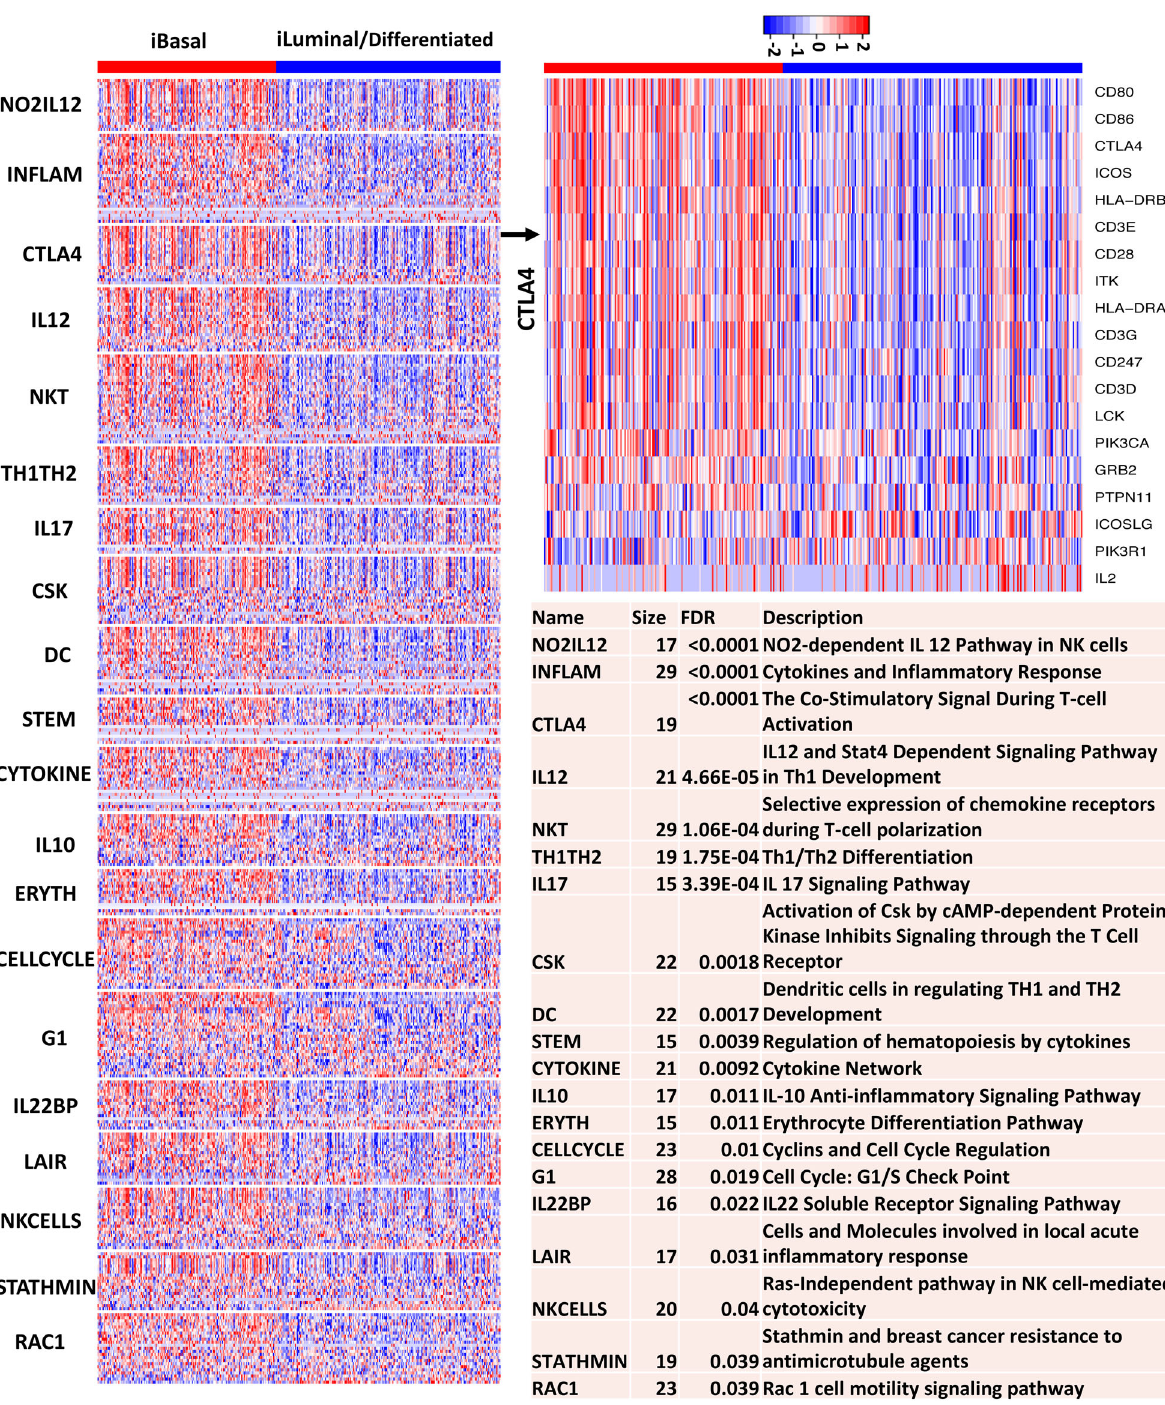
xCell analysis of 64 cell types for each TCGA MIBC sample 35 . The xCell score is based on single-sample GSEA (ssGSEA) and can be used to measure the enrichment of a set of genes among the top of a ranked GE pro fi le. Overall, the basal subtype had higher immune score (P = 7.89E-12, Wilcoxon rank-sum test) and microenviron- ment score ( P = 3.12E-7) than the luminal subtype (Fig. 7b; Sup- plementary Fig. 6). As expected, epithelial cells, keratinocytes, and